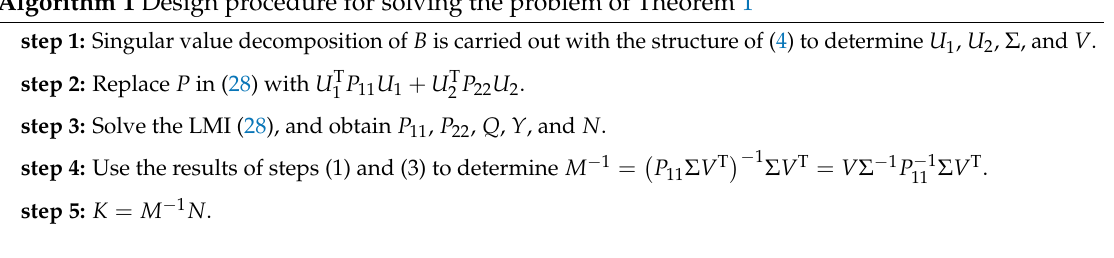
Algorithm 1 Design procedure for solving the problem of Theorem